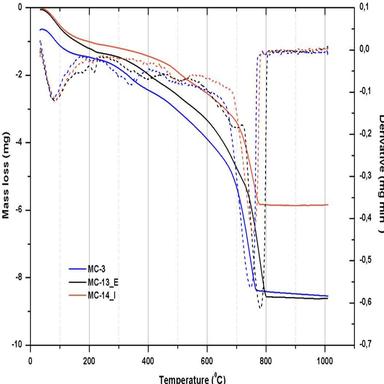
Thermogravimetric analysis (solid line) and derivative thermogravimetric analysis (dashed line) curves of samples MC-3, MC-13_E and MC-14_I.